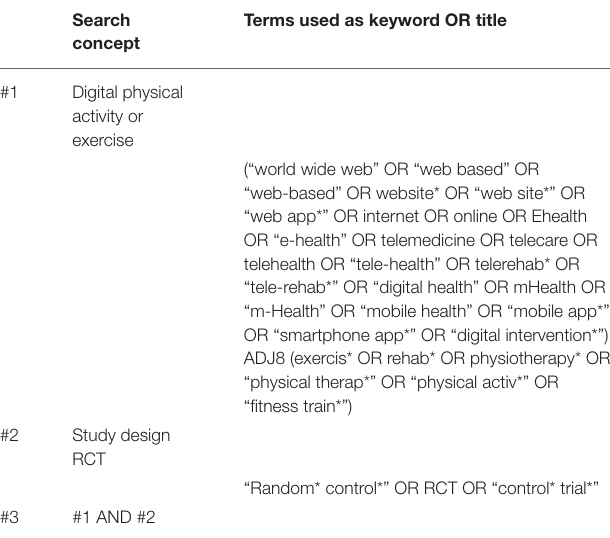
TABLE 2 | Search concepts and terms using